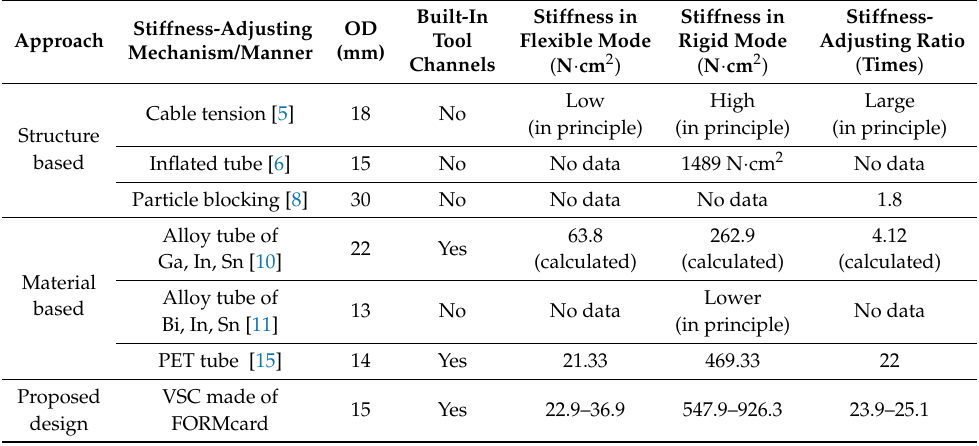
Table 2. Stiffness-adjusting performances of several endoscopic manipulator designs in the litera- ture